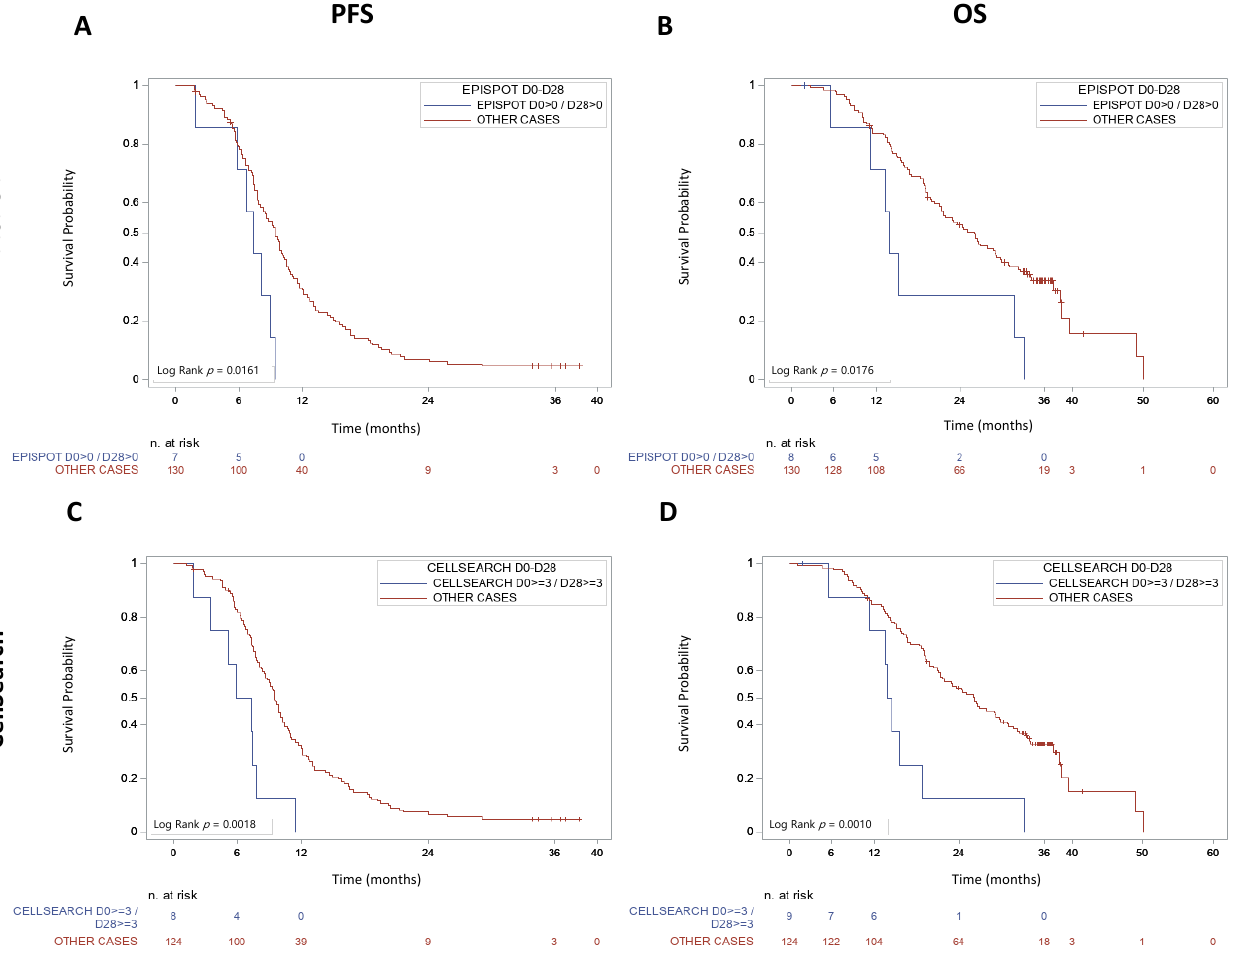
Figure 3. PFS and OS in metastatic CRCs according to the D 0 –D 28 CTC kinetics. Patients were divided into two groups in the function of CTC enumeration at D 0 and D 28 , using the ( A ) and ( B ) CK19-EPISPOT and ( C ) and ( D ) CellSearch ® assays. Univariate analysis confirmed that the early CTC dynamics (both assays), ECOG PS at D 0 , and BRAF mutational status were predictors of PFS and OS. A primary tumor localized to the right colon also significantly correlated with worse OS (Table 2). Table 2. Univariate Cox regression analysis for PFS and OS prediction.